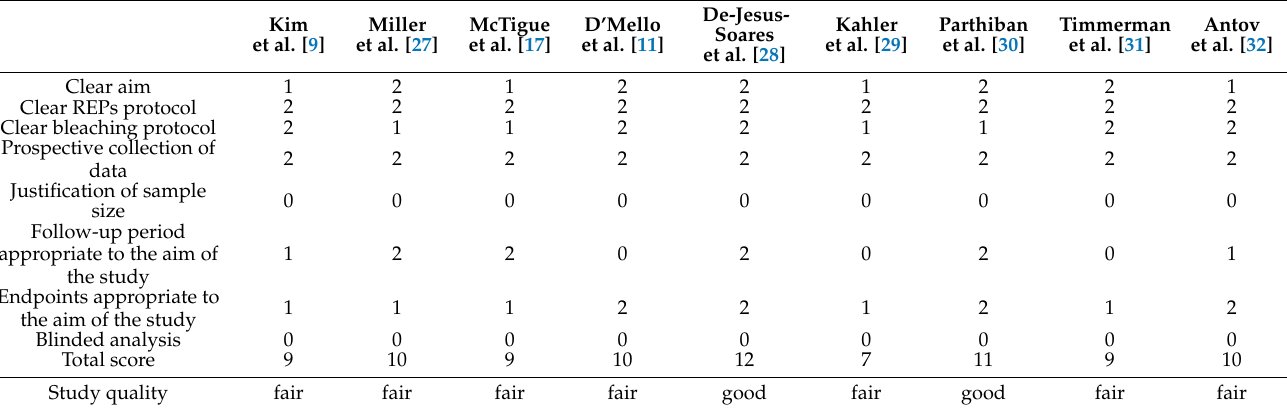
Table 3. Risk of bias according to the modified Methodological Index for Non-randomized Studies (MINORS) scale in in vivo